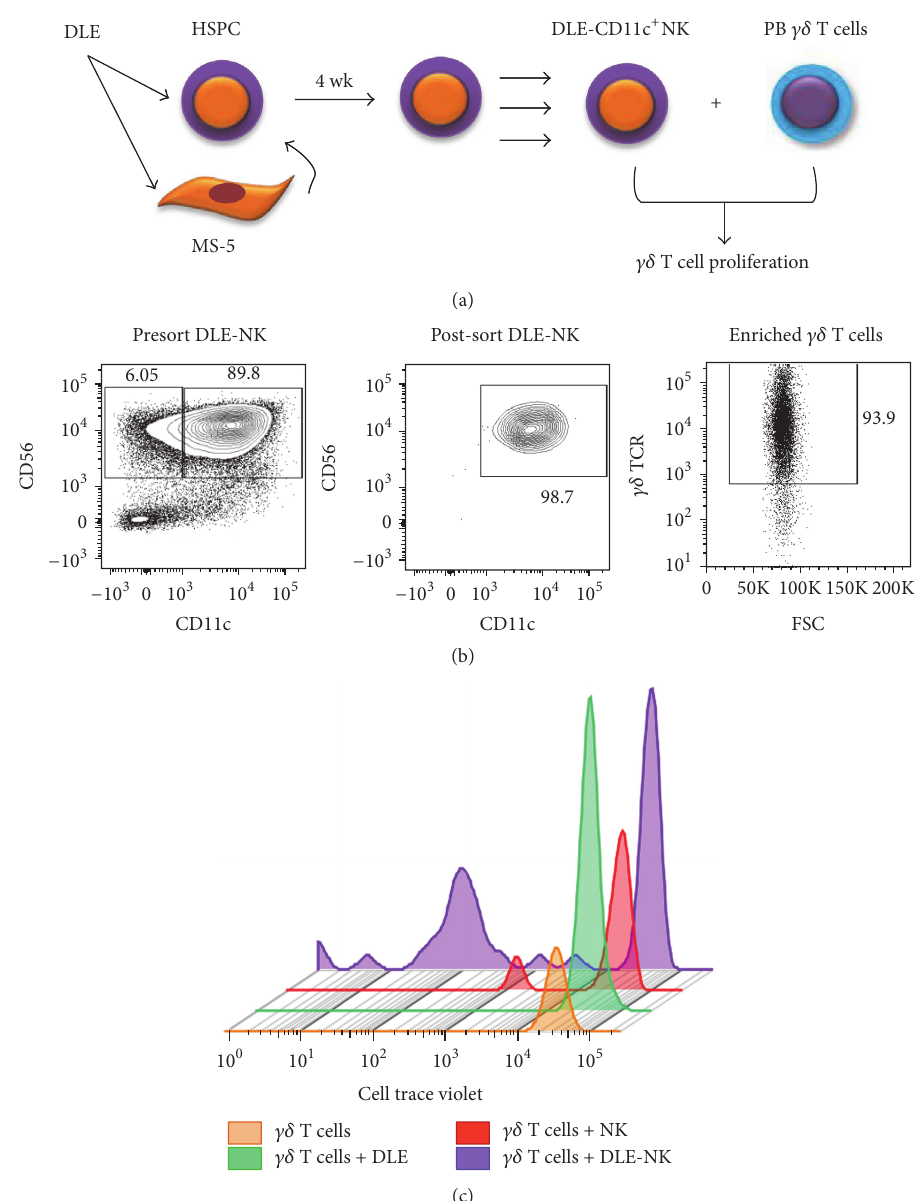
Figure 6: Activation of 𝛾𝛿 T cells as a result of DLE-associated CD11c + NK cell emergent production. 𝛾𝛿 T cells from healthy donors were cocultured with the DLE-derived CD11c + NK cell at a ratio of 2: 1 CD56 + CD11c + NK: 𝛾𝛿 T cell (a). Both NK and 𝛾𝛿 T cell populations were highly purified by flow cytometry sorting before setting the proliferation assay (b). 𝛾𝛿 T lymphocyte proliferation was assessed at 72 hours by dilution of Cell Trace Violet (CTV) dye